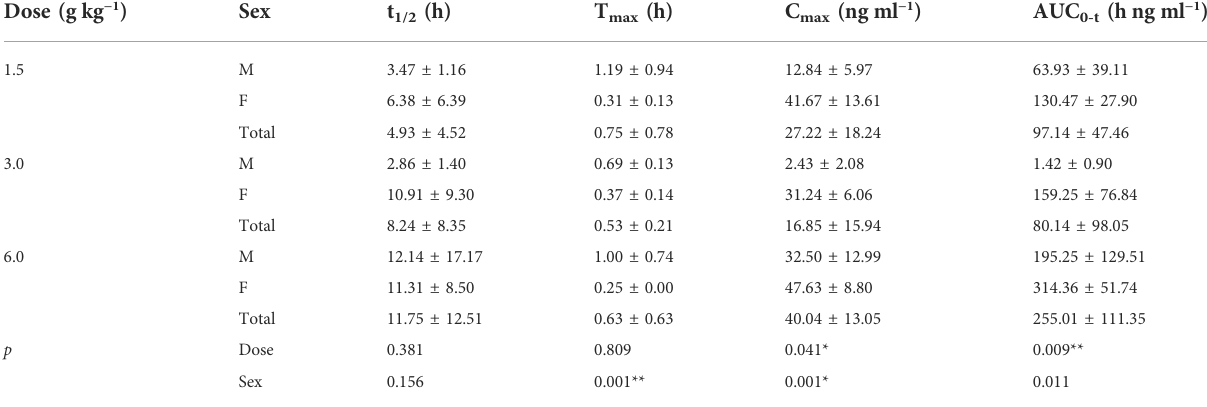
TABLE 9 Pharmacokinetic parameters of piperine after different doses of TYZB in rats (D30). Dose (g kg − 1 ) Sex t 1/2 (h) T max